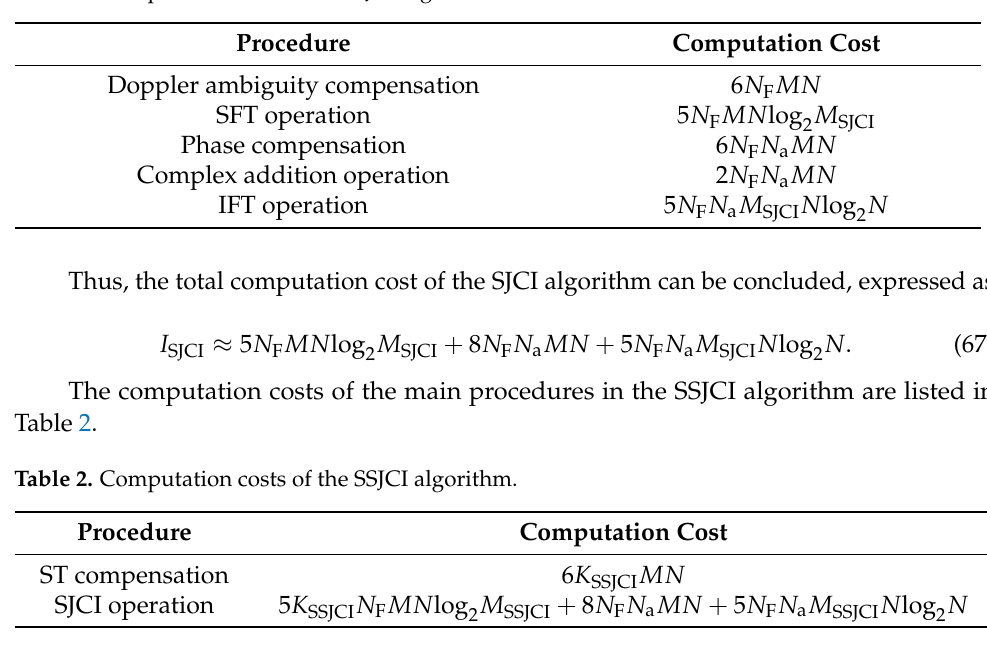
Table 1. Computation costs of the SJCI algorithm.